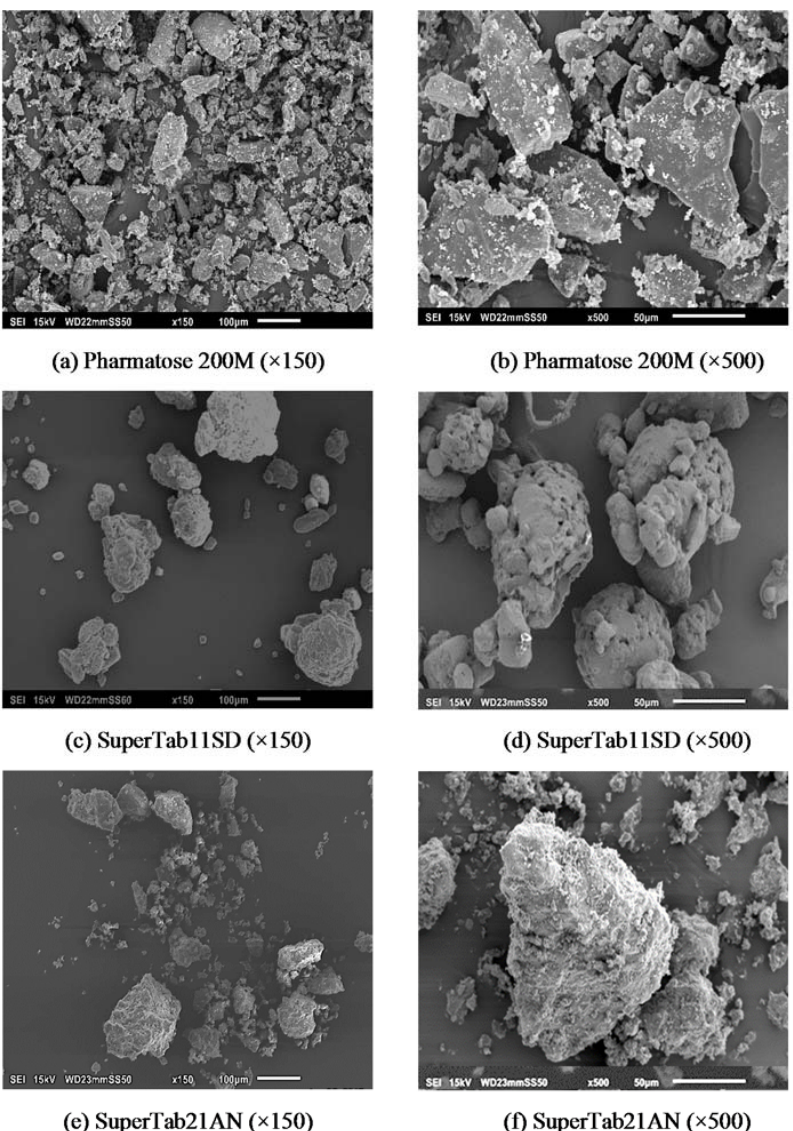
Figure 2. Scanning Electron Microscope (SEM) images of lactose powder.